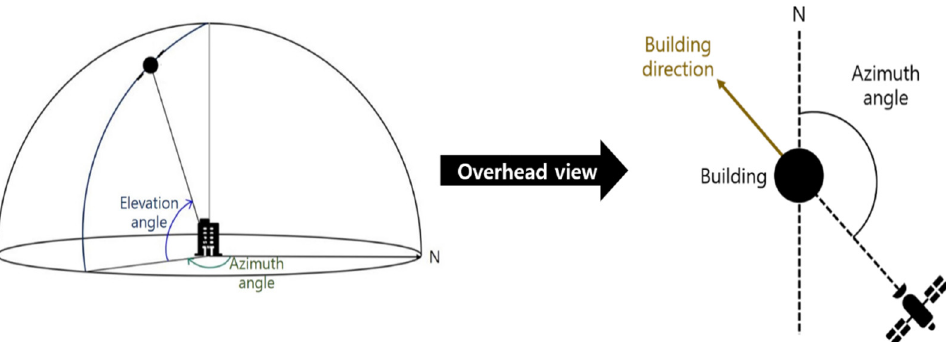
Figure 3. Direction of a building’s relief displacement according to the azimuth angle of the sensor [42].